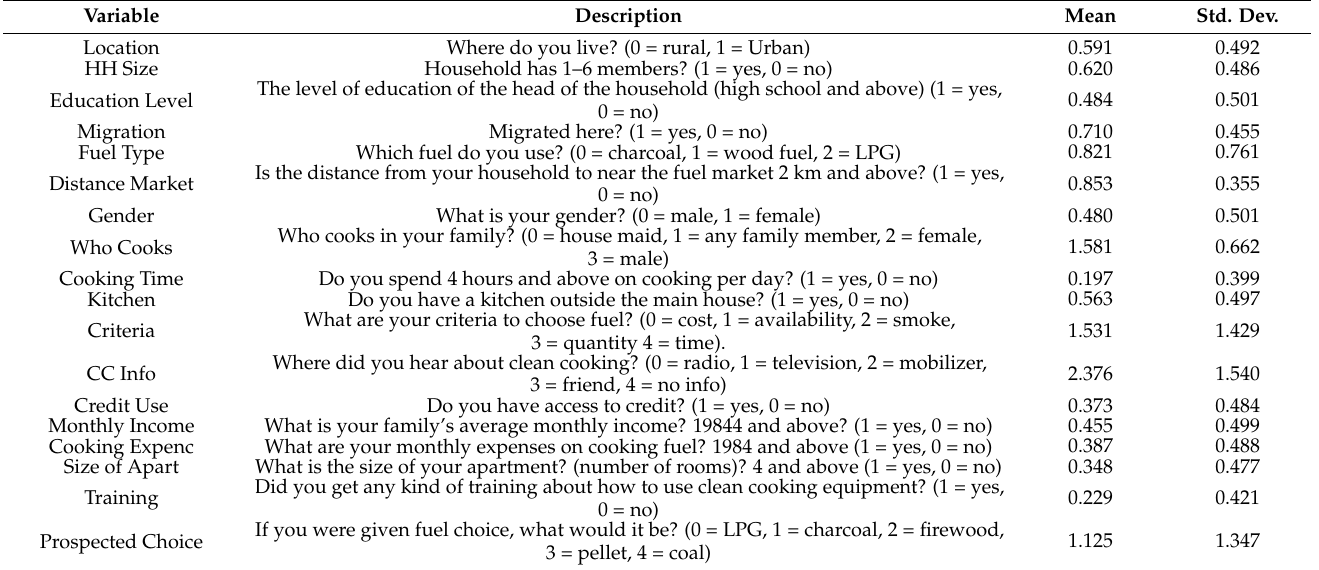
Table 1. Definition and descriptive statistic summary of variables used in multinomial logit regression.